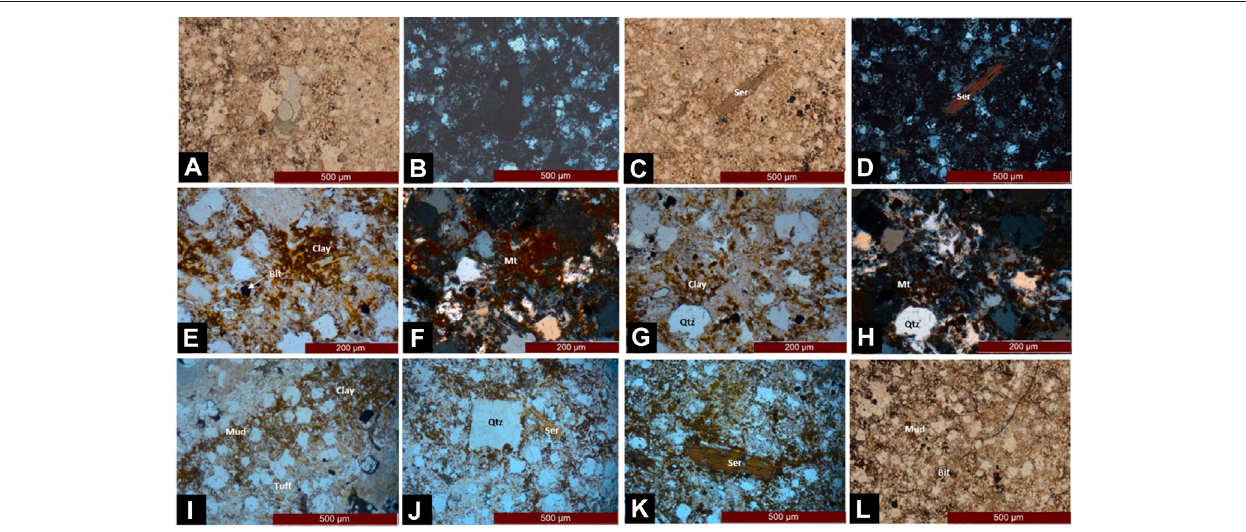
FIGURE3| PetrographiccharacteristicsofthemudrocksampleinLingshanIsland.[ (A) Singlepolarizeraboutsilici fi ed. (B) Orthogonalpolarizeraboutsilici fi ed. (C) Sericite single polarizer. (D) Sericite orthogonal polarizer. (E) Single polarizer. (F) Iron minerals orthogonal polarizer. (G) Clay single polarizer. (H) Orthogonal polarizer. (I) Interbedded single polarizer. (J) Self-shaped quartz single polarizer. (K) Single polarizer. (L) Silici fi ed quartz orthogonal polarizer].